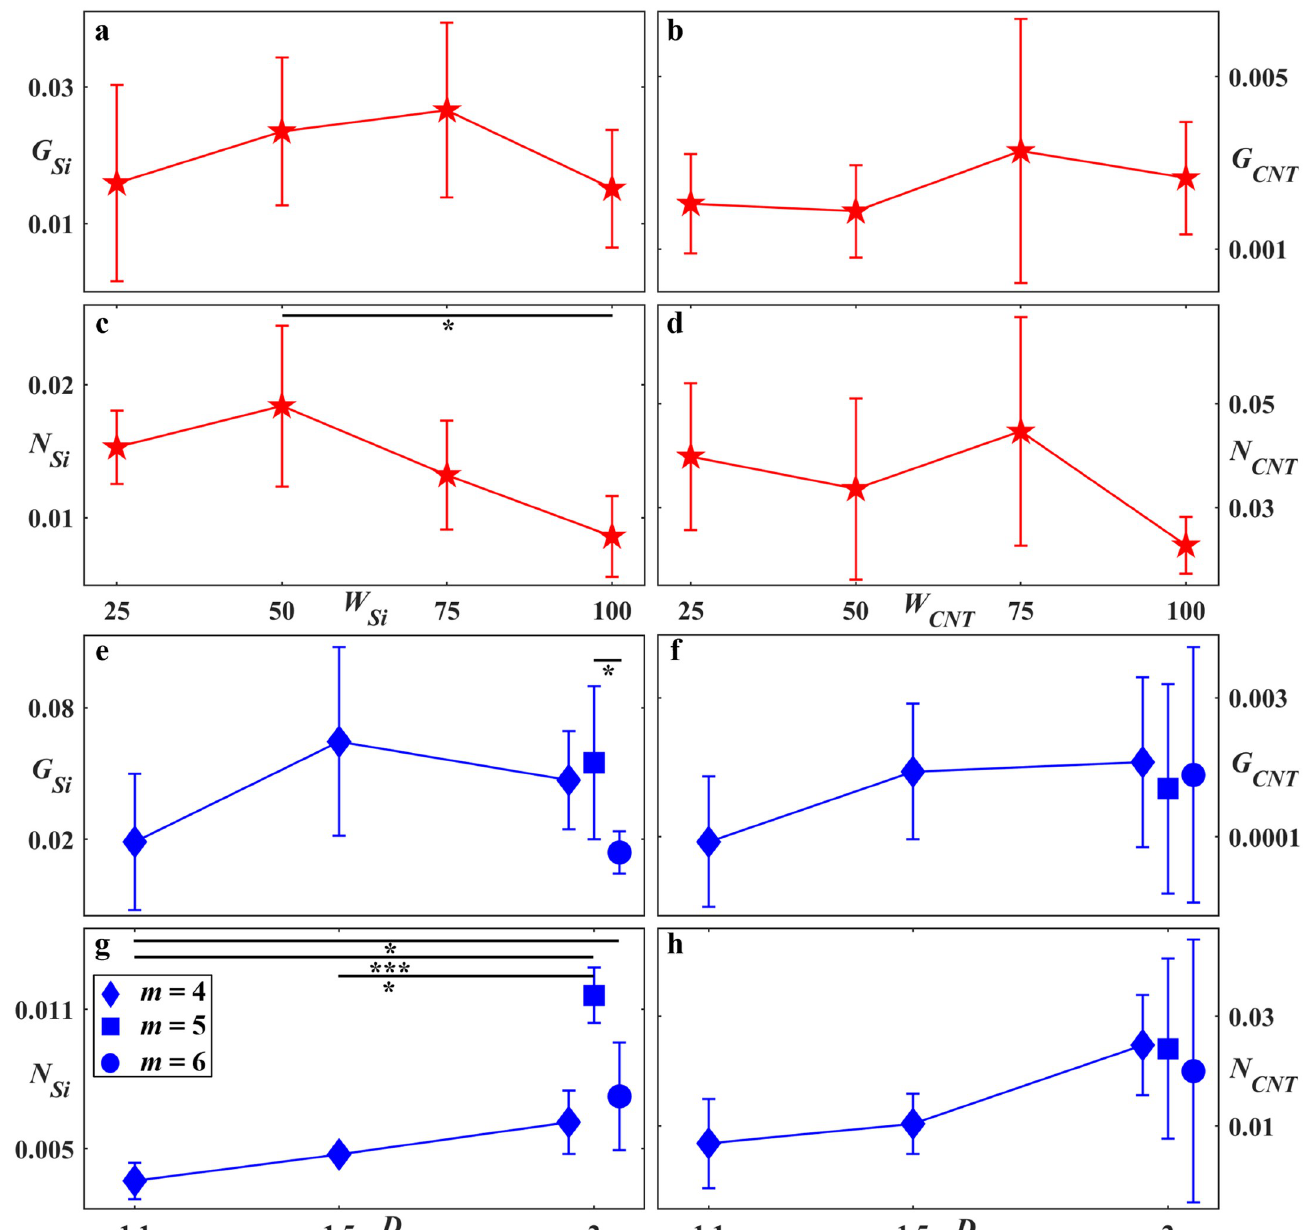
Fig 5. Glial and neuronal behavior for Euclidean and fractal electrodes at 17 DIV. (a) G Si median change with W Si , (b) G CNT median change with W CNT , (c) N Si median change with W , (d) N median change with W . No significance was detected between any Euclidean pairs in panels (a), (b), and (d). In panel (c), Si CNT CNT significance was detected between W Si = 50 and W Si = 100 μ m (p = 0.018). (e), (f), (g), and (h) show G Si , G CNT , N Si , and N CNT median trend with D and m . The 2–4 and 2–6 fractal datapoint are slightly shifted from D = 2 for clarity. The error bars correspond to the 95% confidence intervals. Stars in (c), (e), and (g) indicate the degree of significance: � denotes p � 0.05, and ��� denotes p �